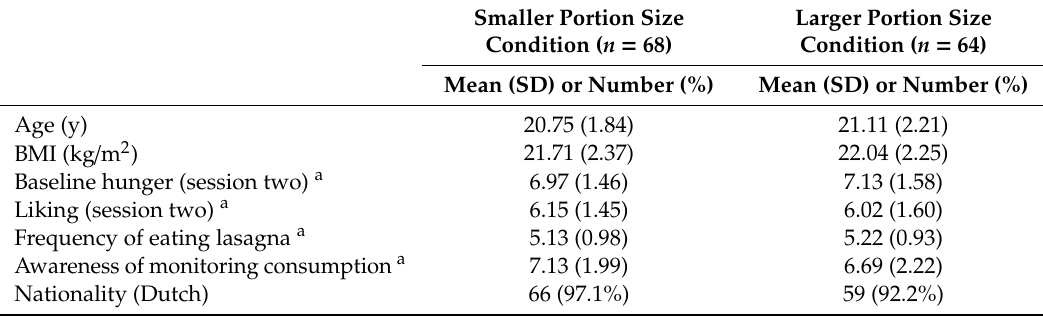
Table 4. Participant characteristics per condition ( n =